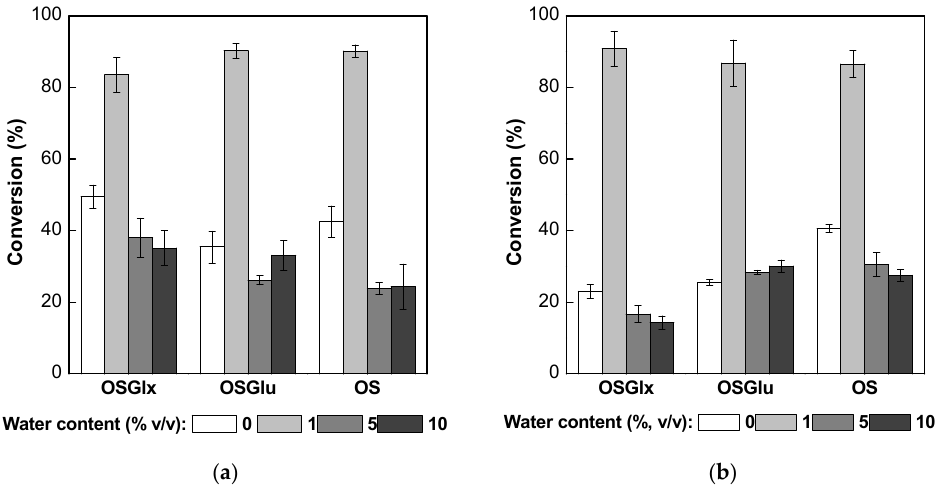
Figure 4. Synthesis of fructose oleate at 35 °C for 12 h of reaction using molar ratio fructose/oleic acid of 1:5 in tert ‐ butyl alcohol/water systems (0.51 IU/mL of solvent) catalyzed by immobilized PFL ( a ) and TLL ( b ). Table 3. Productivities of fructose oleate at 35 °C by enzymatic synthesis in a tert ‐ butyl alcohol/water system. The reactions were catalyzed by both immobilized lipases for 12 h of reaction using a fructose:oleic acid molar ratio of 1:5 and 0.51 IU/mL of